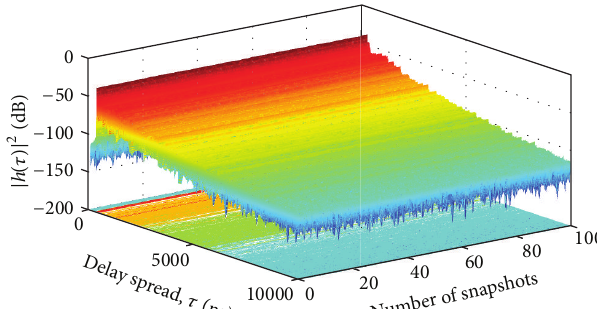
Figure 3: Measured CIR for the maximum Tx-Rx separation dis- tanceandforonepositioninthesquaregrid.Atotalof100snapshots are depicted.